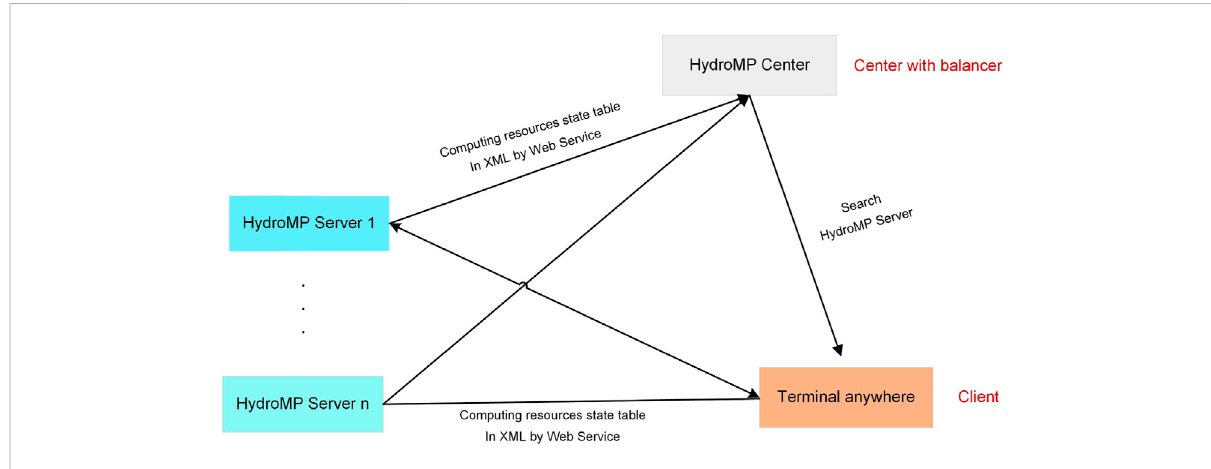
FIGURE 1 The structure of HydroMP platform.